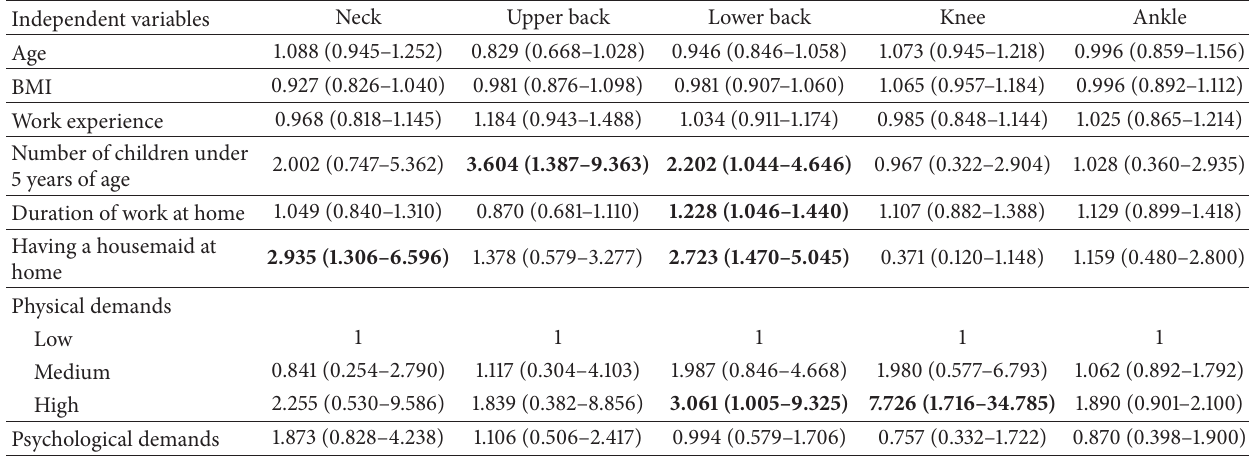
Table 5: Association of different MSD with total physical demands score, total psychological demands score, and selected sociodemographic and work related variables (Multiple Logistic Regression analysis with each